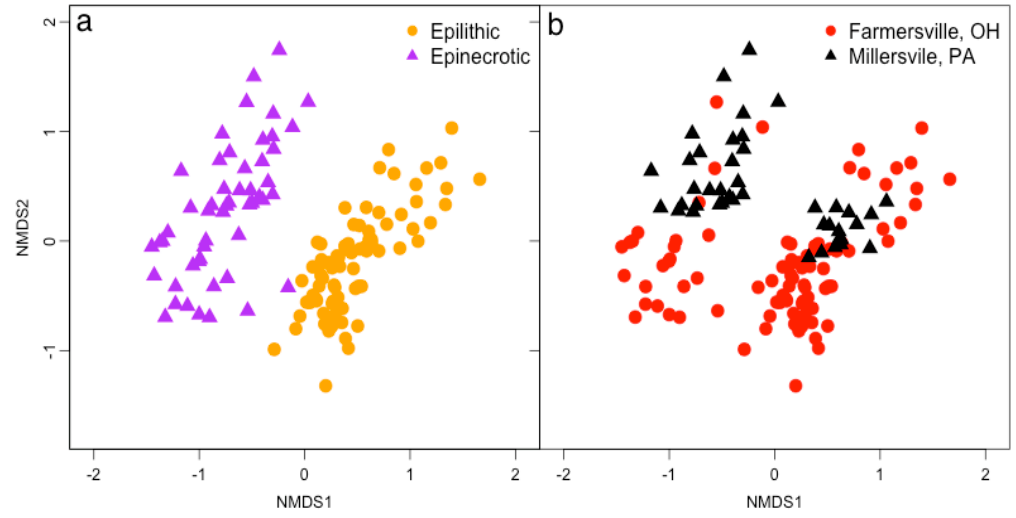
Figure 1. Bacteria community structure was visualized using nonmetric multidimensional scaling (3-D, R 2 = 0.97, stress = 0.18) and overlaid with ( a ) biofilm type and ( b ) location of study and both factors were significant determined by PERMANOVA.